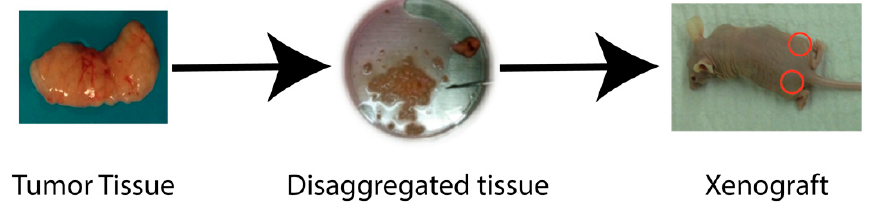
Figure 1. Establishment of xenografts.Tumor tissue obtained from a patient or from an animal model can be used to establish xenografts. Tissue is disaggregated under sterile conditions and implanted into the desired location of recipient mice.